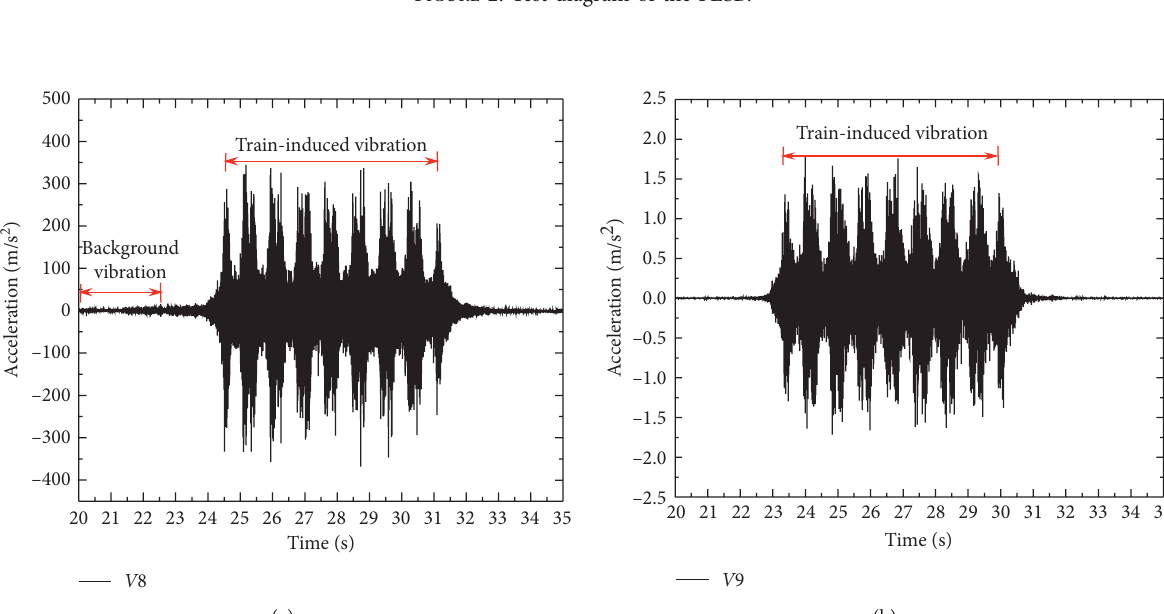
Figure 3: Vibration acceleration time history of (a) the rail and (b) the top board of the